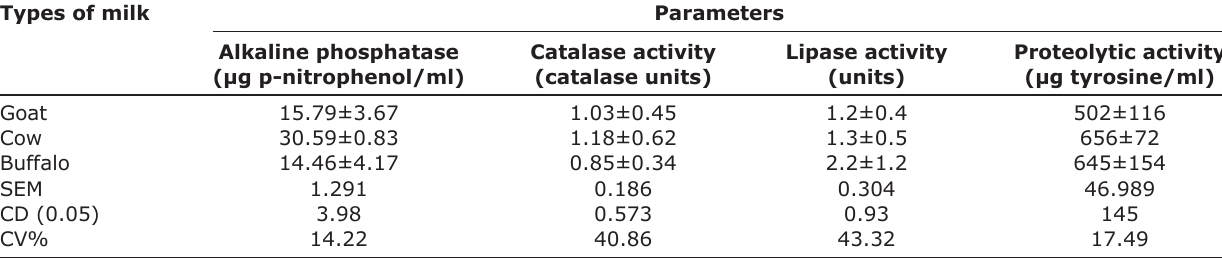
Table-4: Activity of selected enzymes in goat, cow and buffalo milk. Types of milk